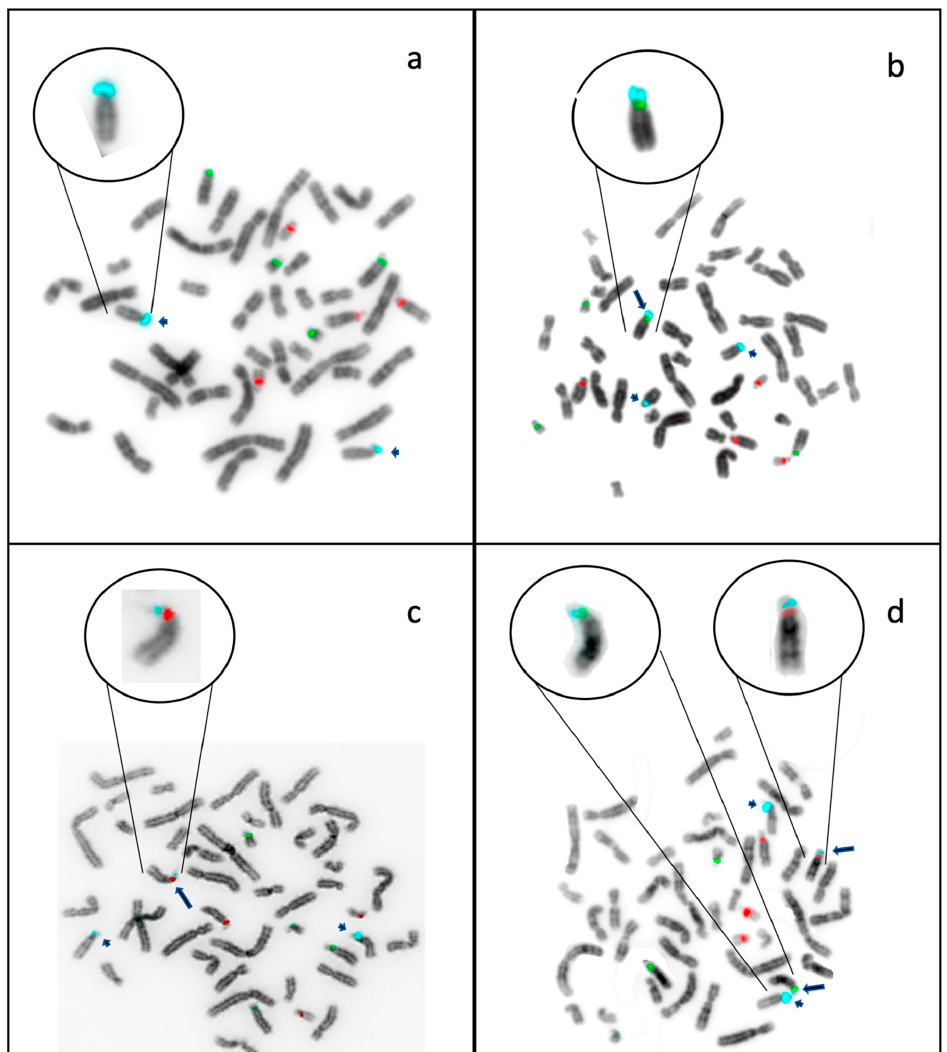
Figure 3. Metaphase plates with merged images of DAPI bands in greys and triple-band filter fluorescence. Fluorescent probes for D13Z1 / D21Z1 in spectrum green, D14Z1 / D22Z1 in spectrum red and D15Z1 in spectrum aqua; ( a ). metaphase from an individual without polymorphism, showing two D15Z1 signals; ( b ). metaphase from a carrier of 13pvar(D15Z1 + ), showing three D15Z1 signals; ( c ). metaphase from a carrier of 14pvar(D15Z1 + ), showing three D15Z1 signals; ( d ). metaphase from a carrier of two polymorphic chromosomes 13pvar(D15Z1 + ) and 14pvar(D15Z1 + ), showing four D15Z1 signals. Short arrows show the normal localization of the D15Z1 signal, long arrows show the polymorphic